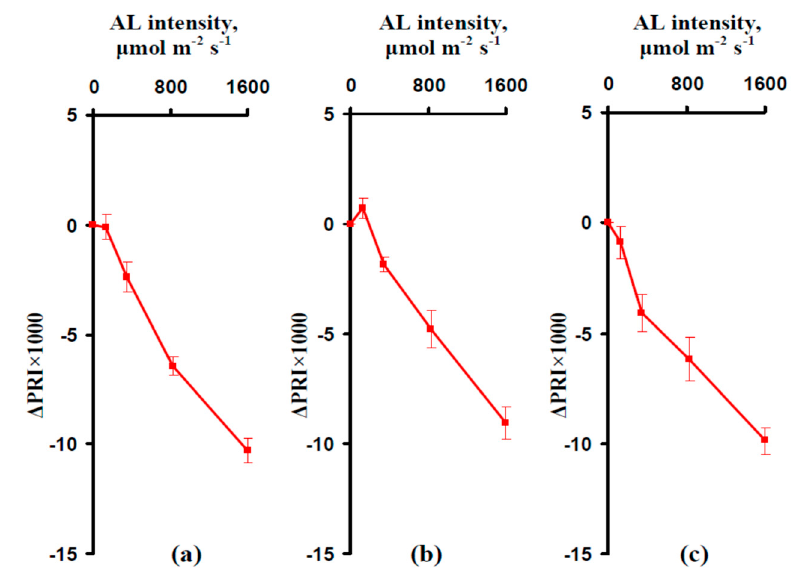
Figure 6. Dependences of the change in PRI ( ∆ PRI), which were calculated on the basis of non-averaged intensity of thereflected light, on the intensity of AL in pea ( a ), wheat ( b ), and pumpkin ( c ) ( n = 6). ∆ PRI was calculated as the difference between the PRI after 5 min of illumination by AL (wavelength 630 nm) and initial PRI (without the AL). PRI was calculated as R 531 − R 570 R 531(570 ) was calculated as R 531(570) First – R 531(570) BG . R 531(570) BG is the absolute intensity of the reflected light at 531 (570) nm before the GYL pulse and R 531(570) First is the first value of the absolute intensity of the reflected light at 531 (570) nm during the GYL pulse.